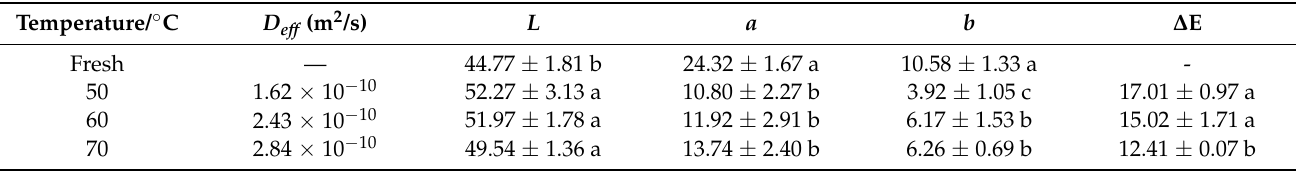
Table 2. The effective moisture diffusivity and color values of blood-flesh peach at different tempera- tures. Values were presented as mean ± sd. Different letters in each line mean significant difference as determined by Tukey’s post hoc test ( p <